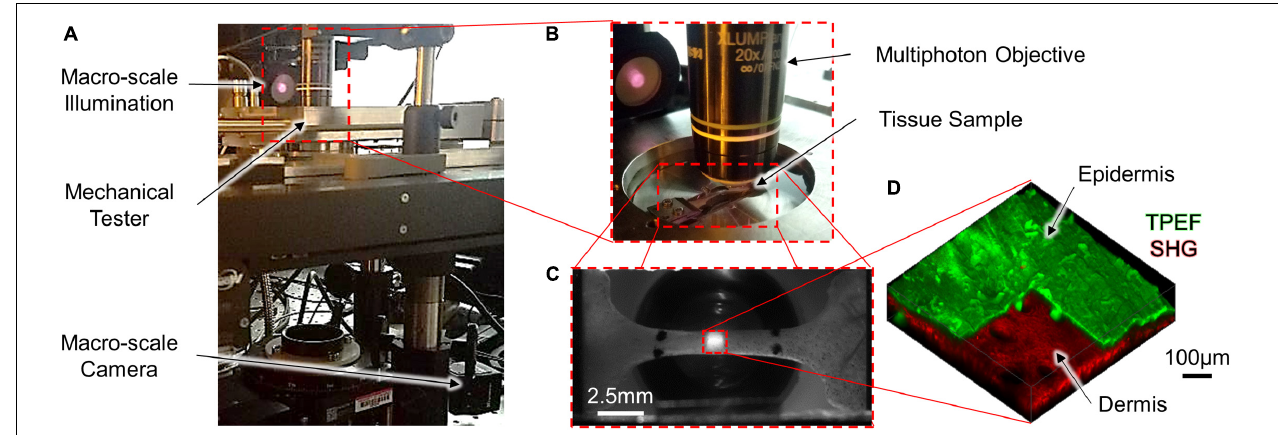
FIGURE 1 | A mechanical tensile testing device integrated with a multi-scale imaging system (A,B) was used to collect macro-scale 2D images [ (C) ; scale bar represents 2.5 mm] and micro-scale 3D MPM image volumes [ (D) ; scale bar represents 100 µ m]. To highlight the difference in scale between the macro- and micro-scale ROIs, the red dashed square in the center region of panel (C) represents the relative size of the ROI collected in panel (D) . At the micro-scale, both SHG and TPEF image volumes were collected, and the pseudo-colored TPEF volume shown in panel (D) is cutout to highlight the layers of the skin.